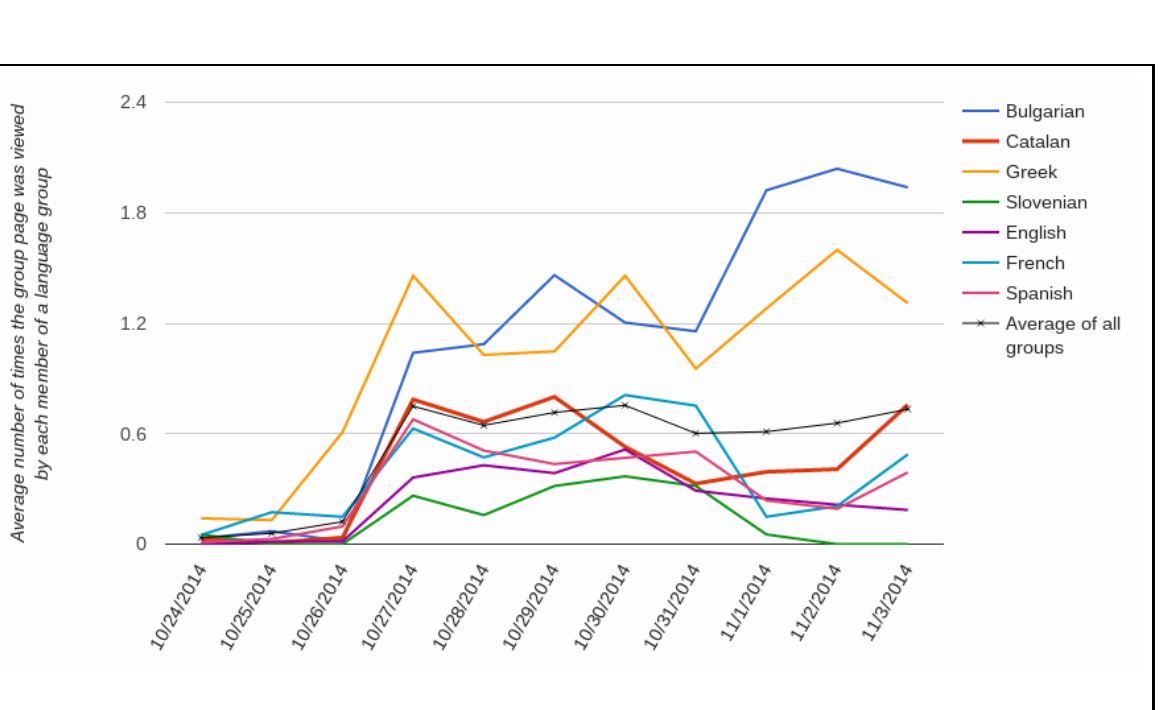
Figure 15. Group Pageviews during the first